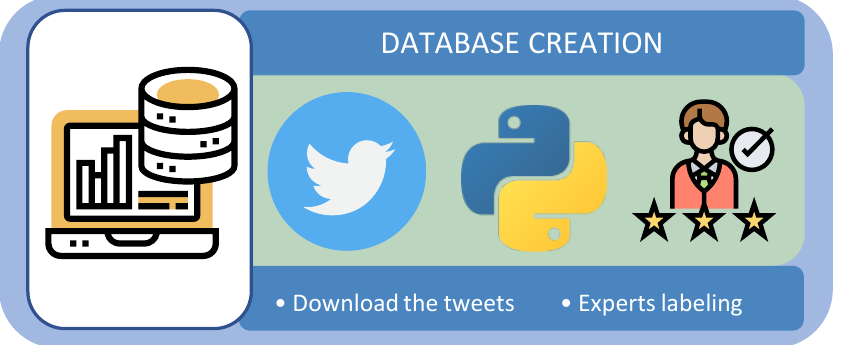
Figure 2. The creation of the Xenophobia database consisted of downloading tweets through the Twit- ter API jointly with the Python Tweepy library. Then, Xenophobia experts took it upon themselves to manually label the